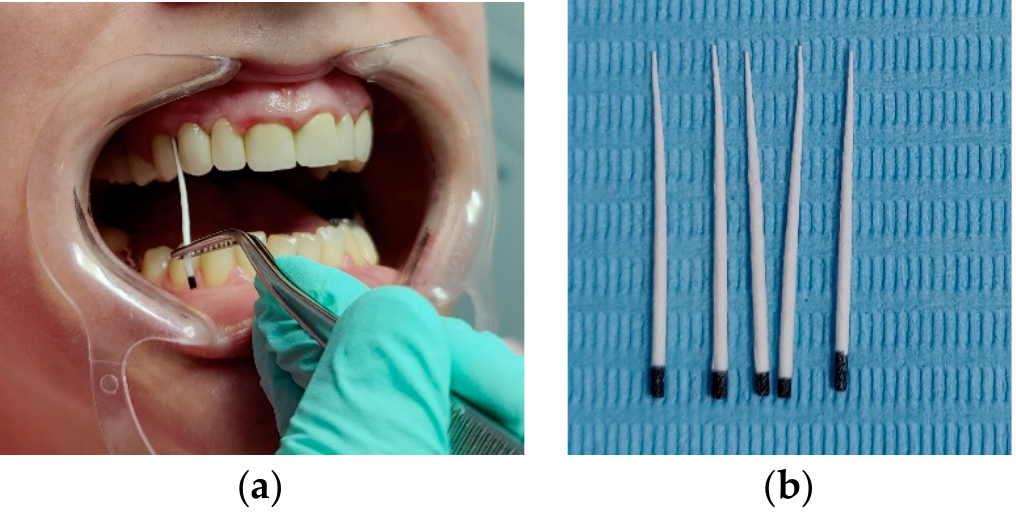
Figure 1. Practical aspects of GCF sampling. ( a ) the action of performing GCF sampling collection in premolar area in first quadran maxilla; ( b ) sample of filter paper strips of standardized 2 × 8 mm size with slightly rounded tips used in the performing GCF sampling action .